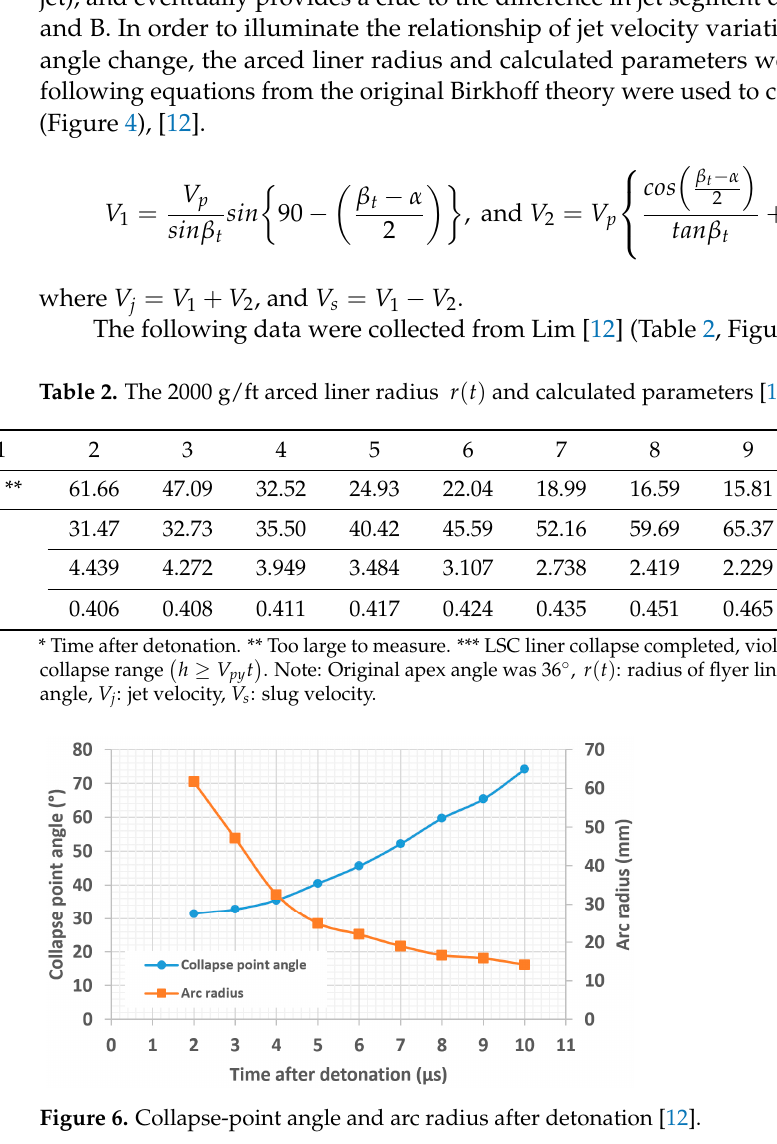
Figure 7. Jet and slug velocity of 2000 g/ft LSC [12].